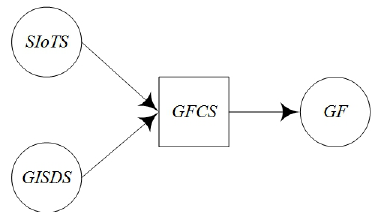
Figure 7. Sensing IoT service